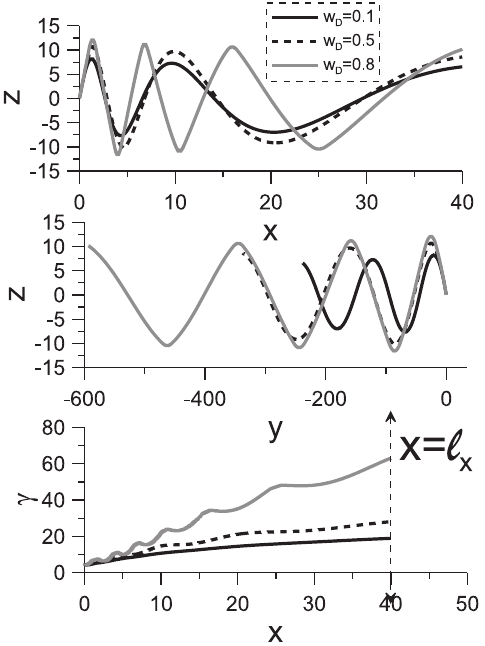
Fig. C1. Three particle trajectories and energy as a function of x co- ordinate are shown for various w D . We use v D = 0 . 01, β x = 10 − 3 and β z = 10 − 2